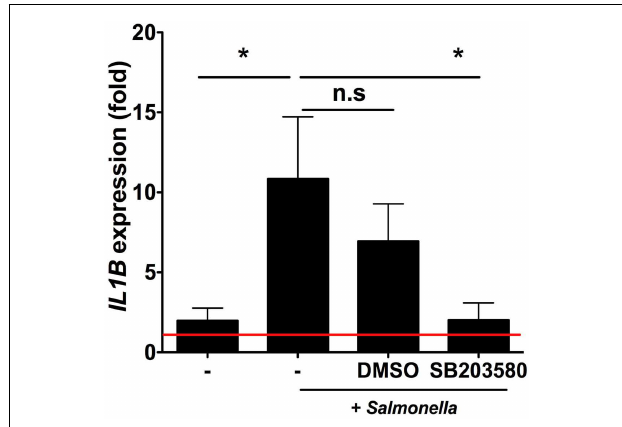
FIGURE 5 | Intestinal stromal cell responses to Salmonella require RIPK2/p38MAPK signaling . Figure 5 shows relative fold changes in IL1B expression determined by qRT-PCR in iSCs left uninfected or after 6h of infection with live Salmonella at an MOI of 10, in the presence of bacteria alone ( − ), DMSO or SB203580. Data show mean ± SEM fold increases in IL1B expression by iSCs under the indicated conditions isolated from n = 6 surgical patients. * p <